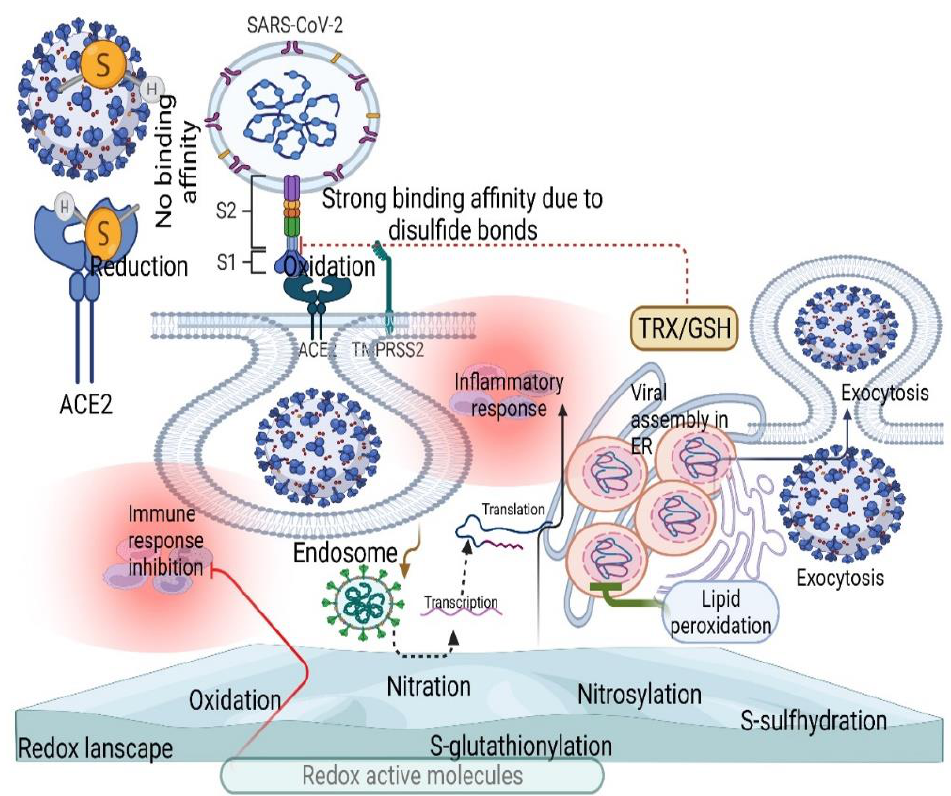
Figure 4. Changes in the redox landscape (thiol-based redox mechanisms) facilitate viral fusion and replication. Disulfide bonds induce a stronger affinity between SAS-COV-2 and ACE2, while thiol compounds do not induce binding affinity between SARS-CoV-2 and ACE2 (red inhibitory mark). Disulfide activation by the allosteric mechanism facilitates initial viral fusion by activating various redox molecules (endocytosis). In contrast, redox imbalance induces lipid peroxidation to inhibit viral replication in the ER (green inhibitory mark).